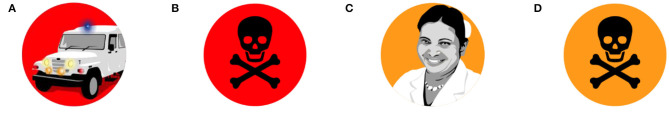
Pictograms (A,B) represent seeking urgent medical care and high risk, respectively. Pictograms (C,D) represent seeing a health worker and lower risk, respectively. Reprinted from (29).